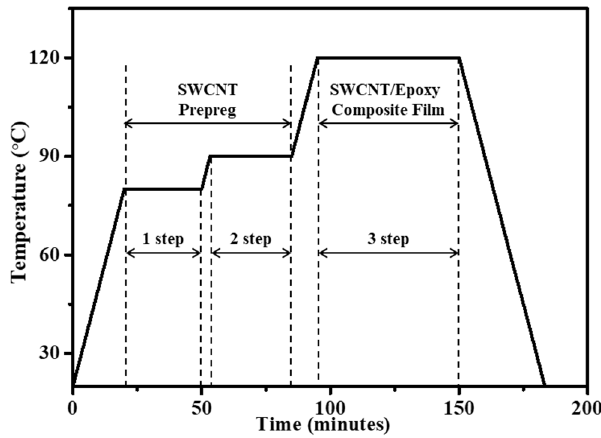
Figure 2. A 3-step cycle graph designed with temperature depending on the time.